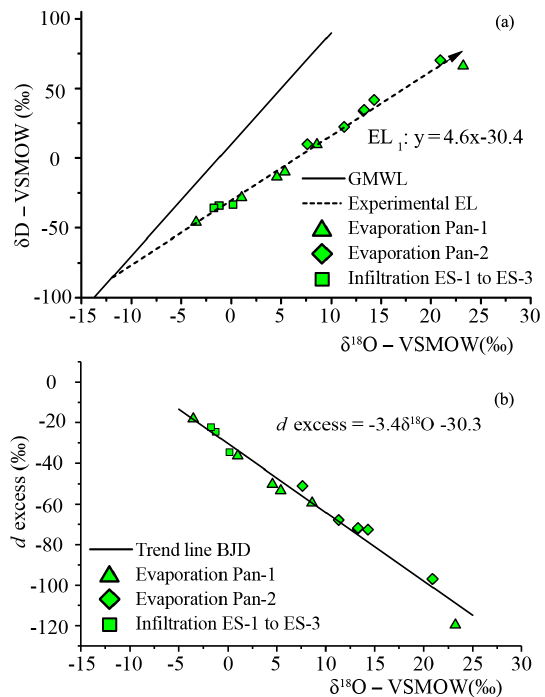
Figure 3. The relationship between δ D and δ 18 O (a) and between d excess and δ 18 O (b) of water samples from evaporation experi-